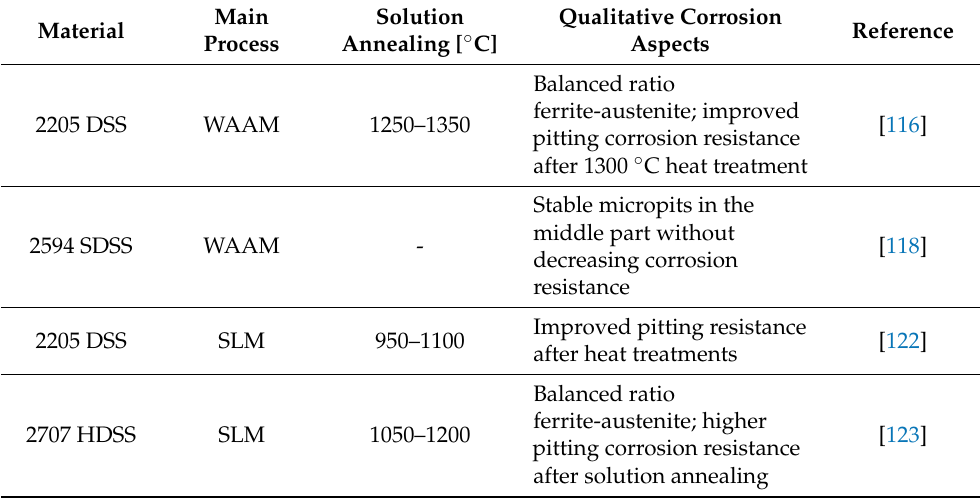
Table 4. Different DSS types processed by AM and post-AM heat treatments revealing critical issues related to the corrosion